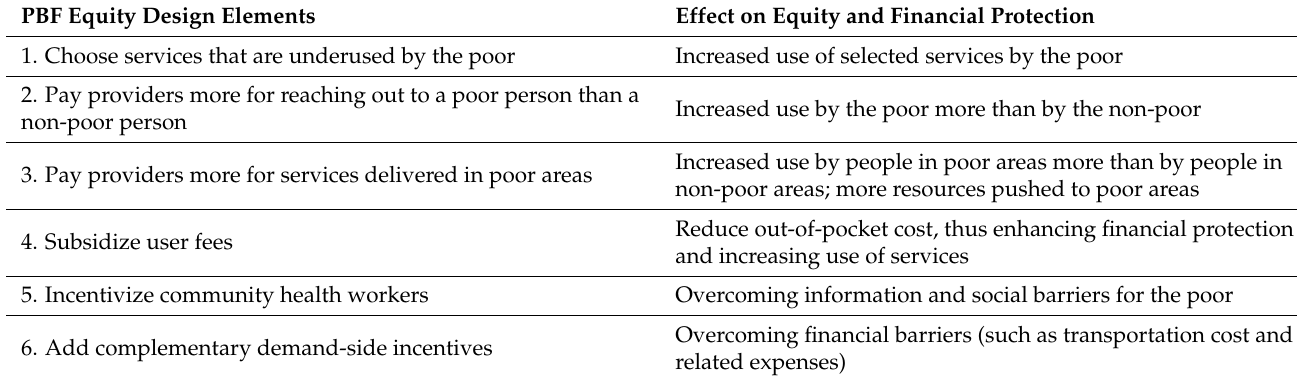
Table 1. PBF equity design elements and anticipated effect on